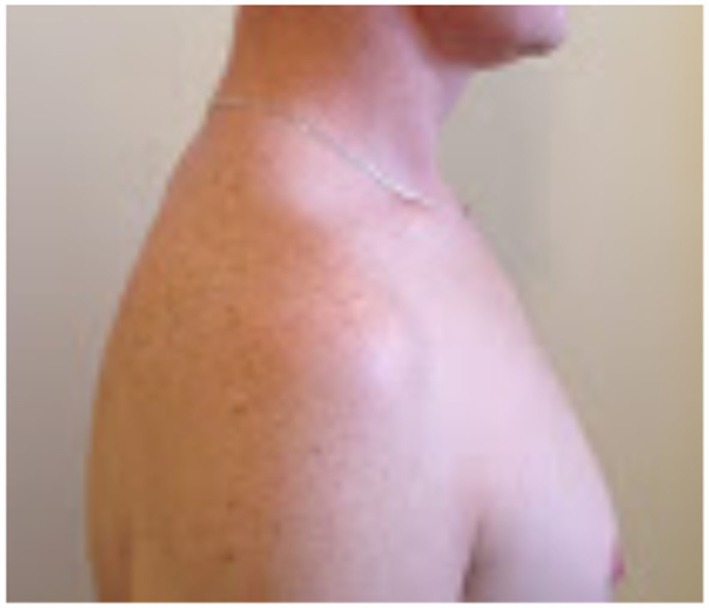
Right lateral view.